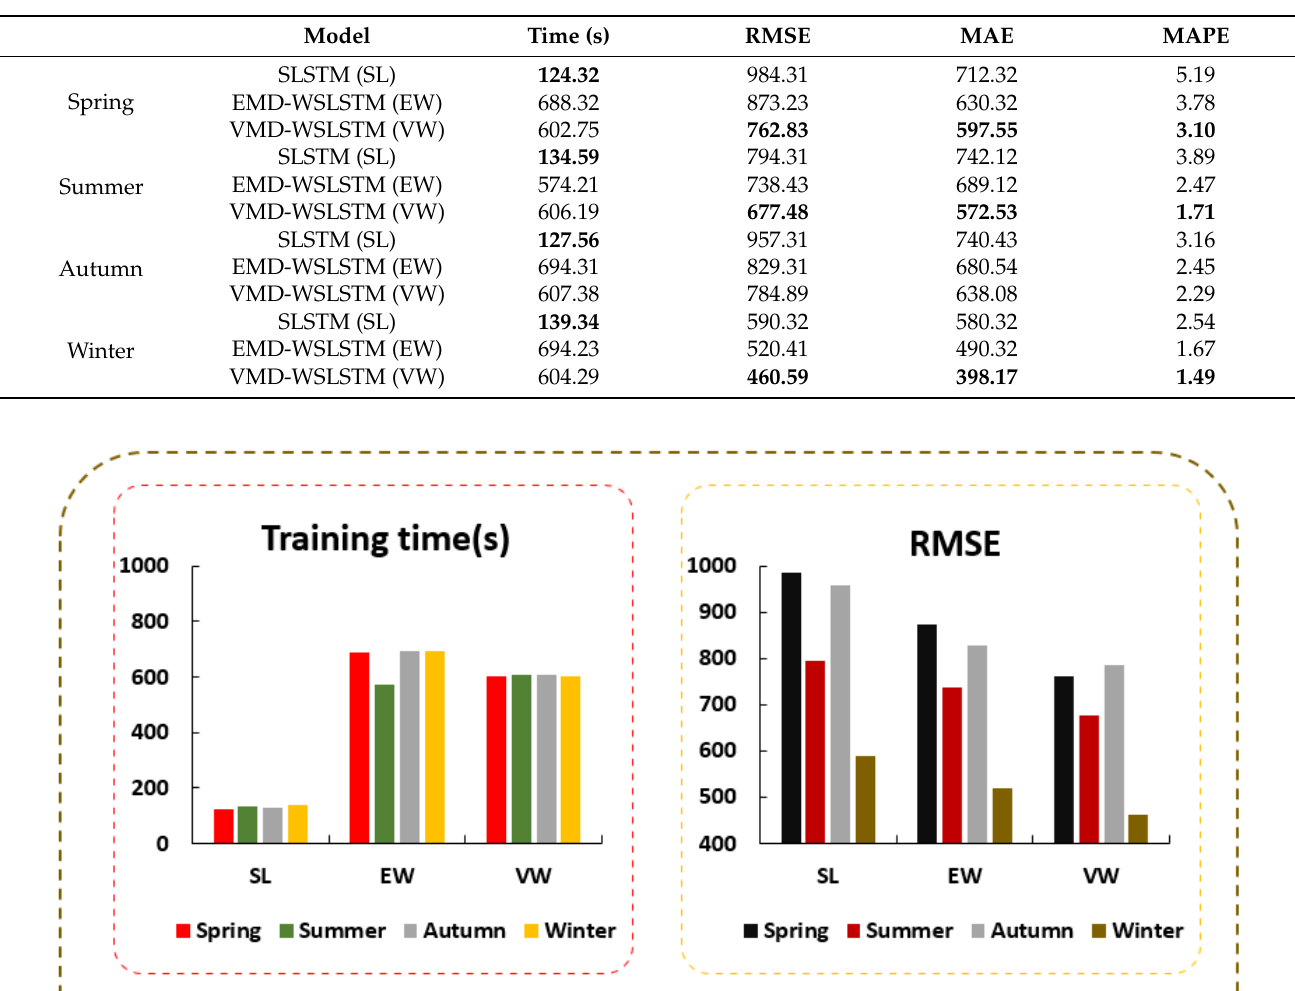
Table 7. Prediction results of different decomposition methods (the best results of each model are bolded).